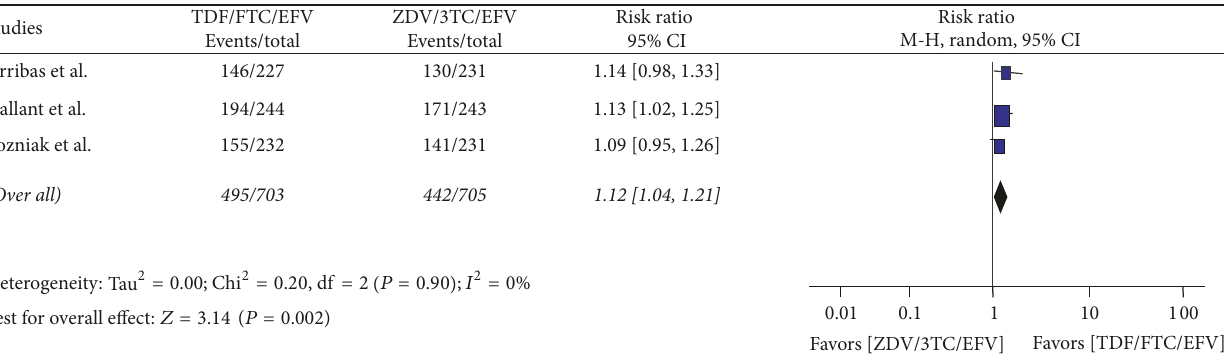
Figure 3: Forest plot of viral load suppression to less than 50 HIV RNA copies/ml in TDF arm as compared to ZDV arm in ART na¨ıve HIV-1 infected